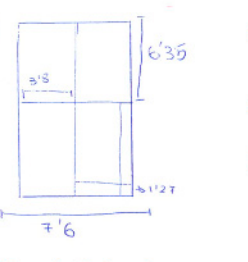
Figure A3. Statement of the task “the play center” translated into English (source: prepared by the authors).